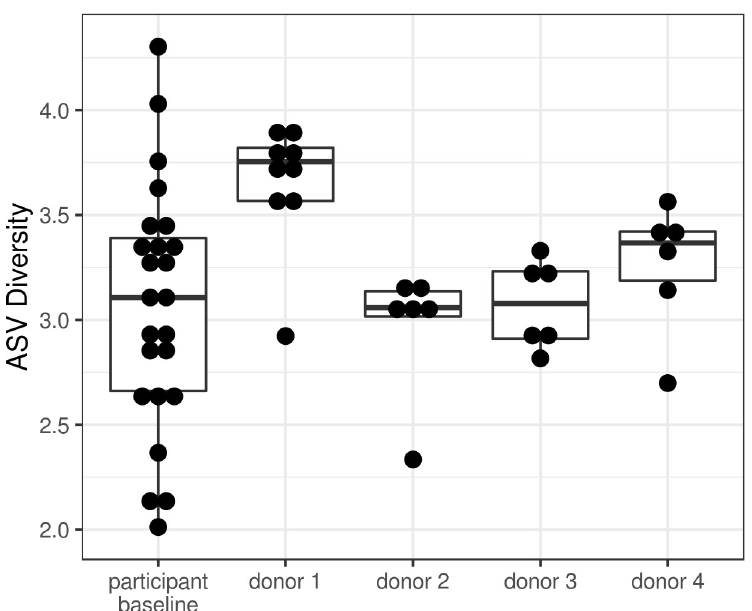
Fig 3. Boxplot displaying the amplicon sequence variant (ASV) diversity (Shannon diversity index) identified in lean donor samples and baseline samples of participants with obesity.